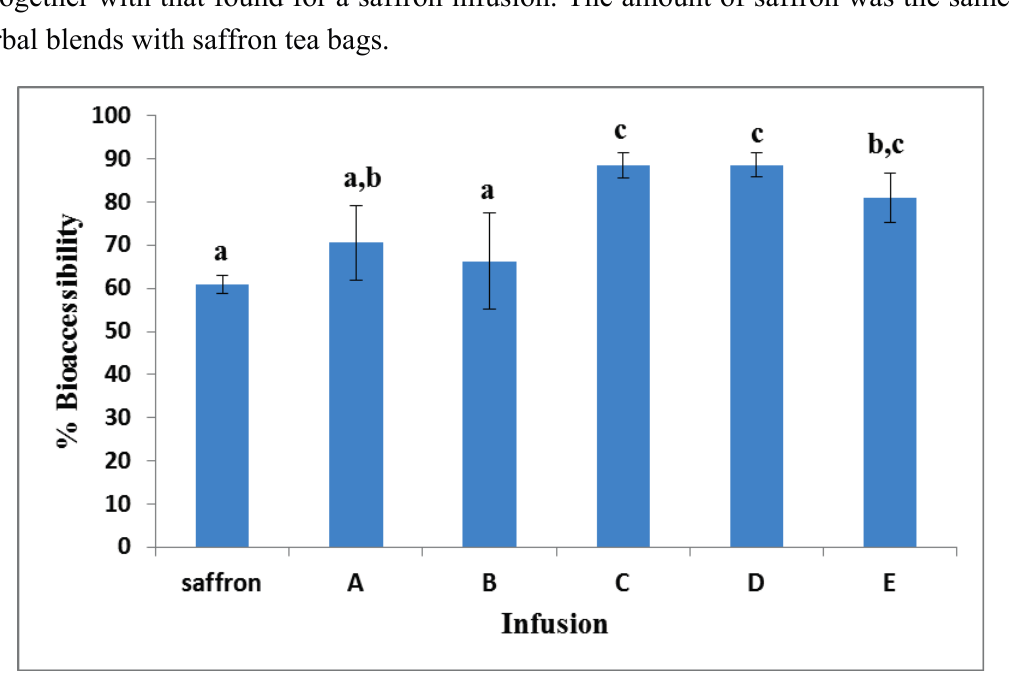
Figure 1. The % bioaccessibility of total crocetin sugar esters (CRTSEs) in infusions of